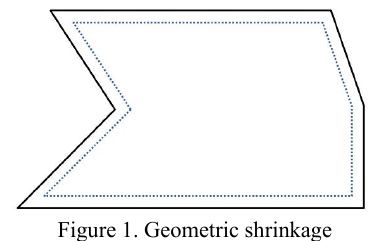
Figure 1. Geometric shrinkage